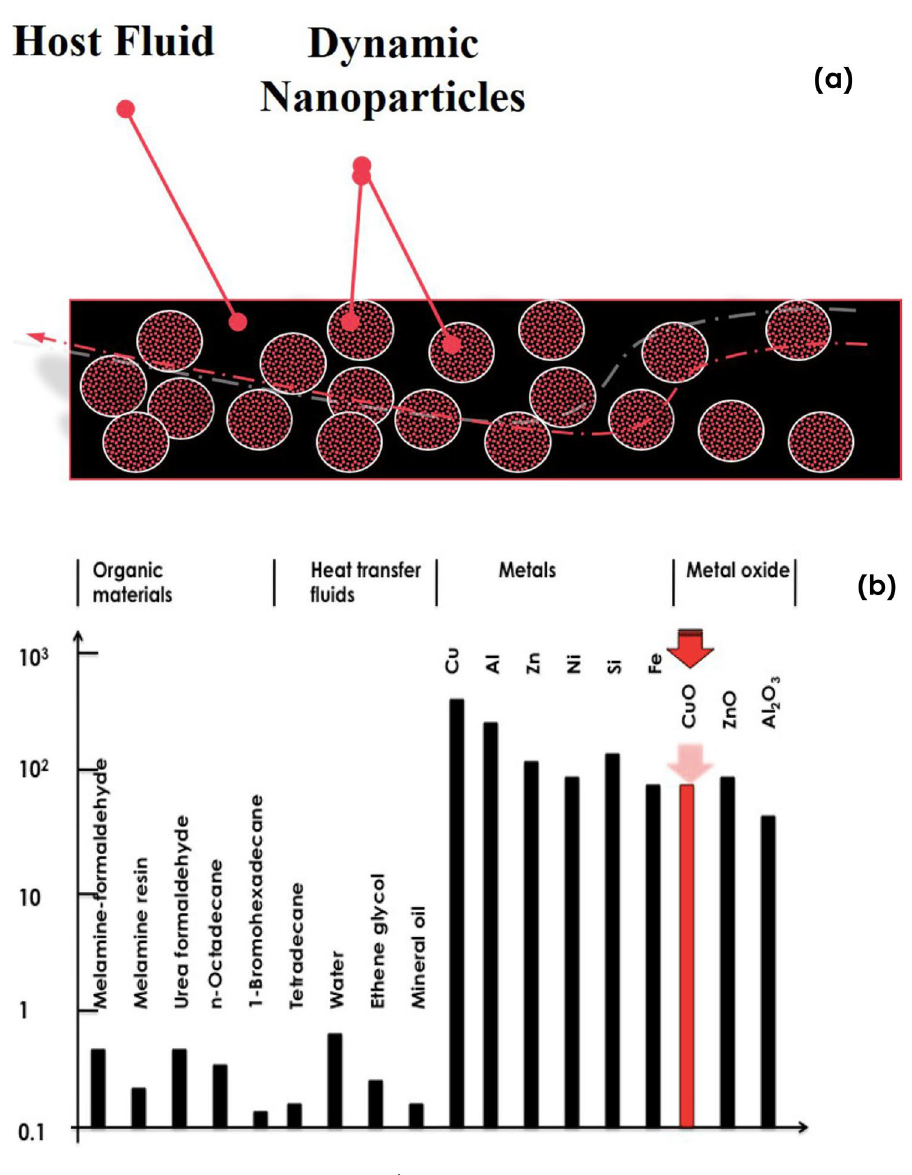
Figure 1. ( a ) Universal configuration of a nanofluid consisting of nanoscaled particles in suspension in a host standard fluid, ( b ) comparative scale of thermal conductivity of various materials: organic materials, standard heat transfer fluids, metals and their